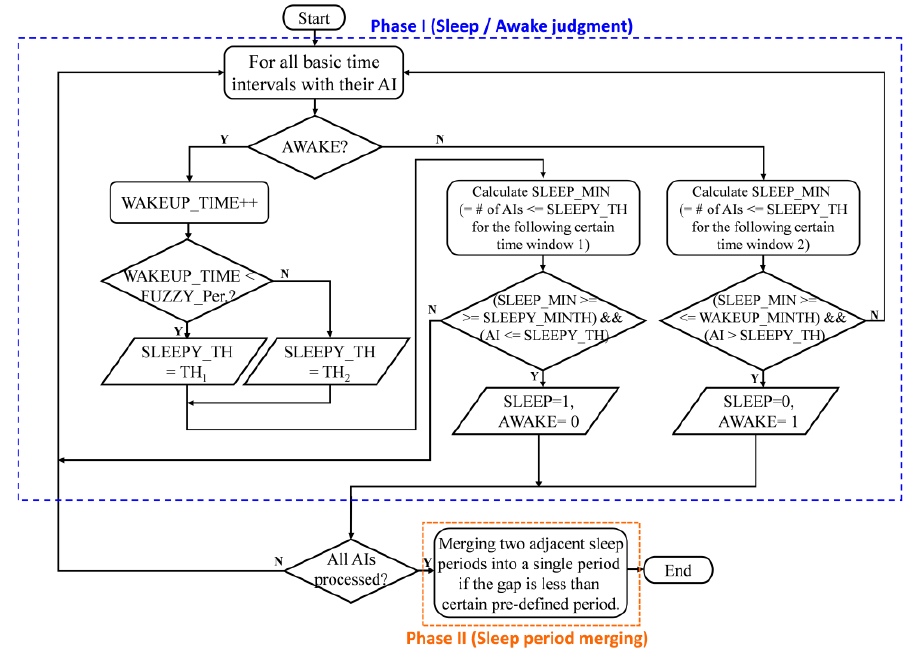
Figure 4. Flow chart of the proposed smart sleep duration detection algorithm based on AI model.